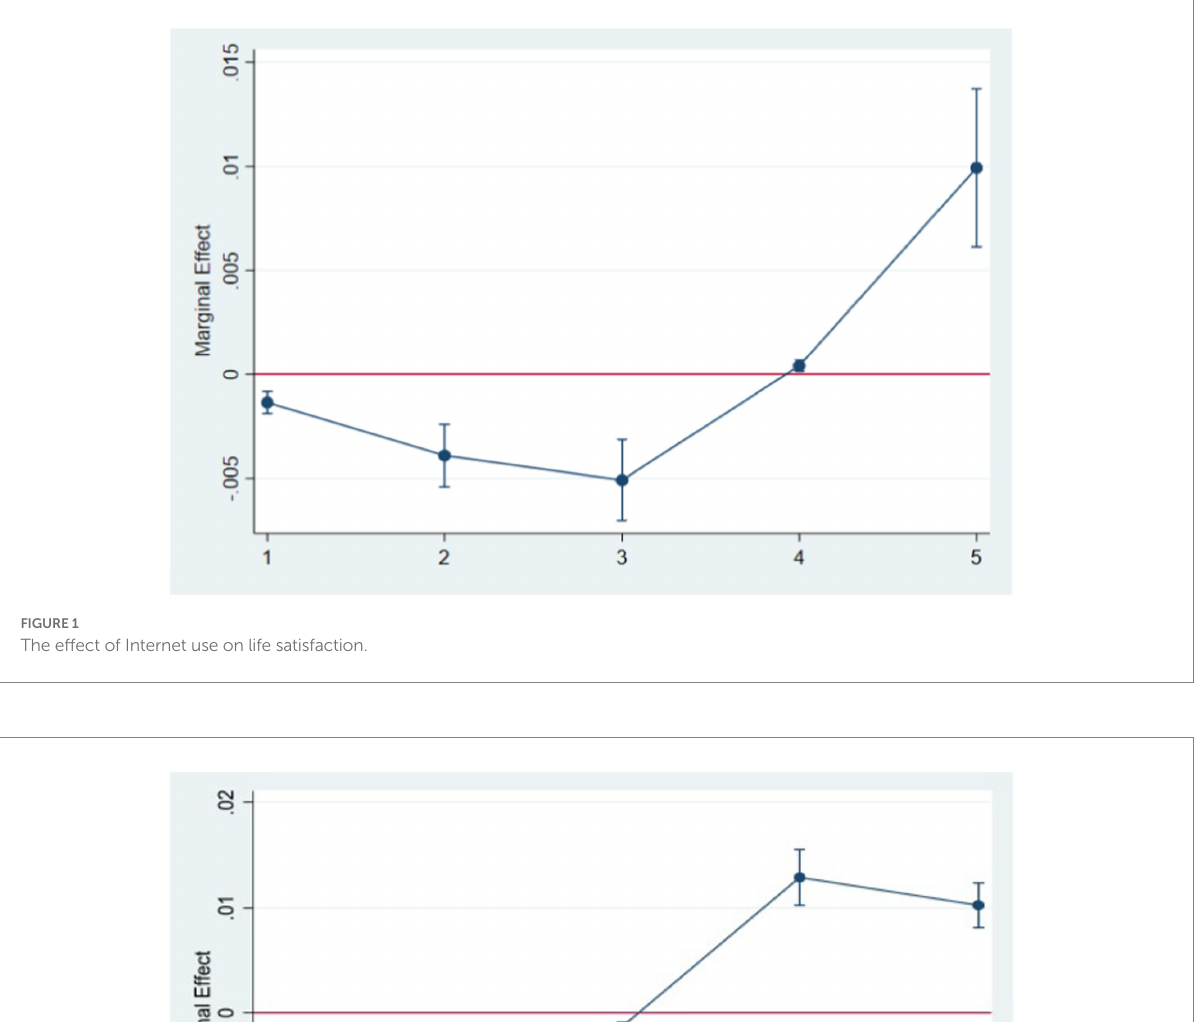
FIGURE 2 The effect of Internet use on physical